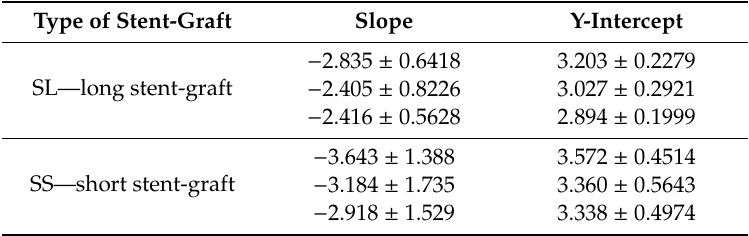
Table 1. Shape factor describing long and short stent-graft with the use of linear